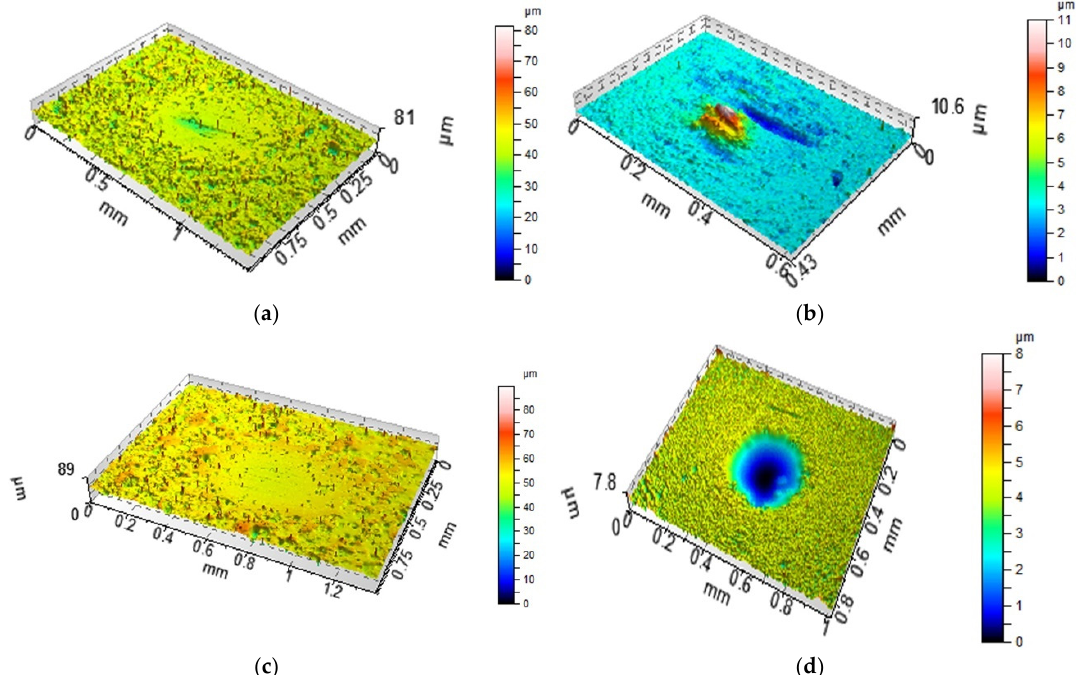
Figure 10. Isometric views of disc VB1 ( a , c ) and co-acted balls ( b , d ) after tests A ( a , b ) and B ( c , d ). Table 6 and Figure 11 present the results of test C.